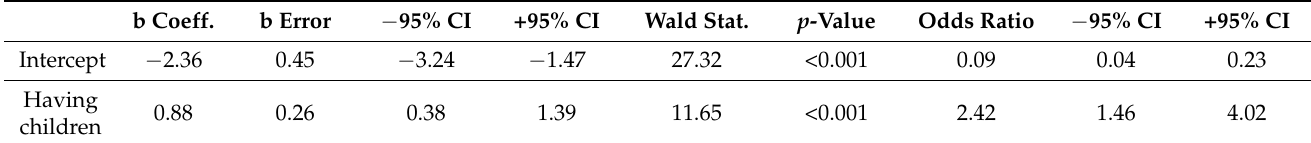
Table 5. Model of logistic regression analysis of the variables emotional fear reactions and having children.